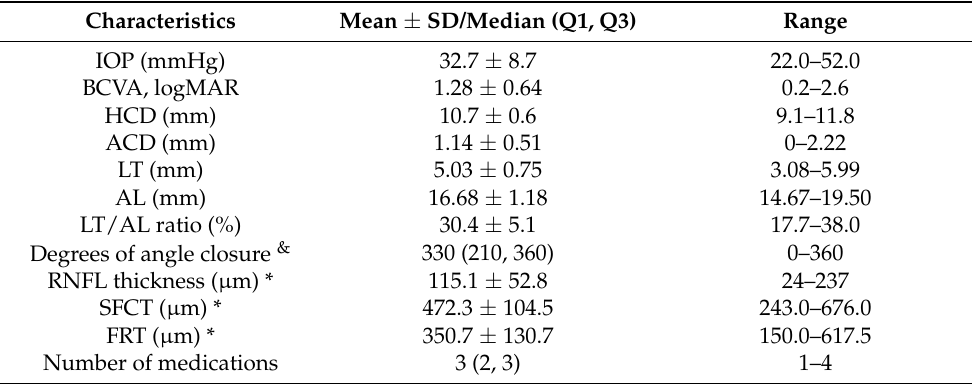
Table 1. Baseline characteristics of 37 patients with complex nanophthalmos (n = 45).